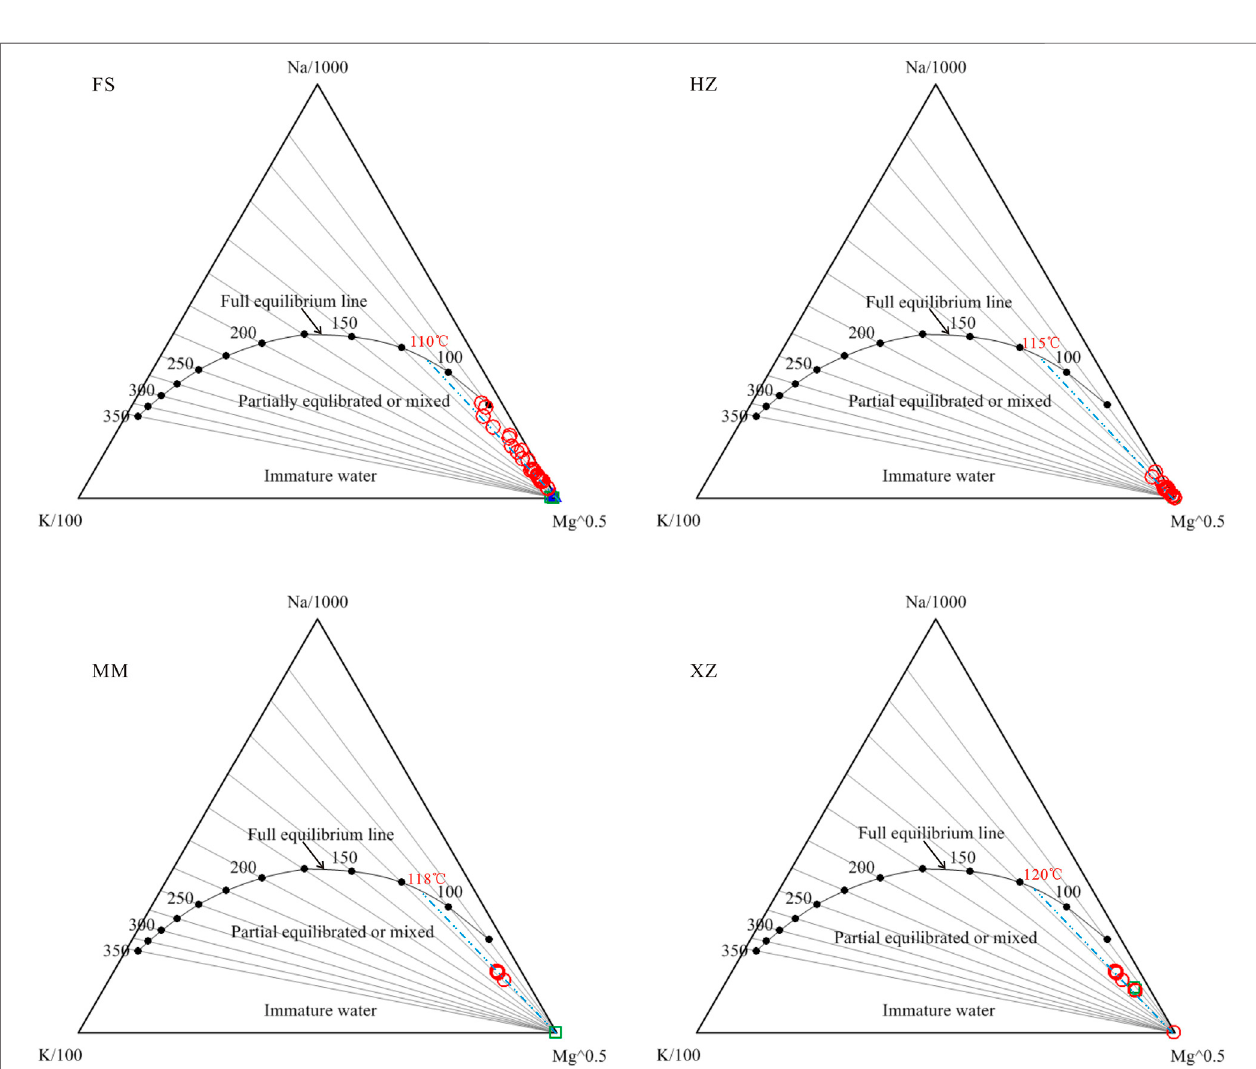
FIGURE 6 | Na-K-Mg triangle diagrams for geothermal fl uid from FS, HZ, MM, and XZ geothermal fi elds. Red circle-geothermal water, blue triangle-river water, green square-shallow groundwater.